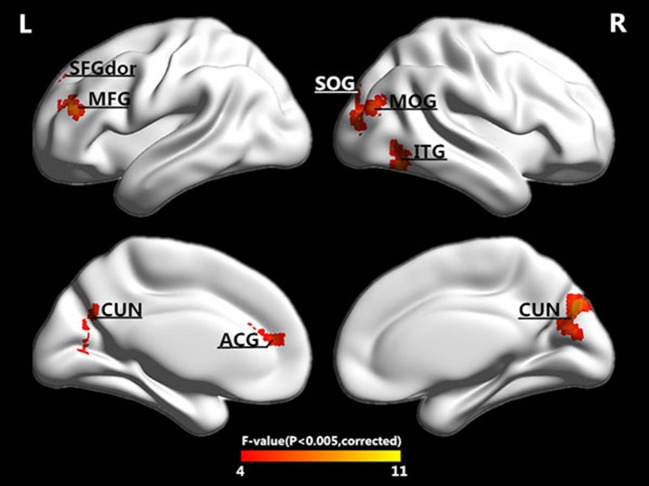
Surface-rendered images showed the differences between the control and patient groups after adjusting for age and sex. The regions showed exhibited different complexities among the four groups. See Table 2 for a complete list of these regions (threshold P < 0.005, GRF corrected).